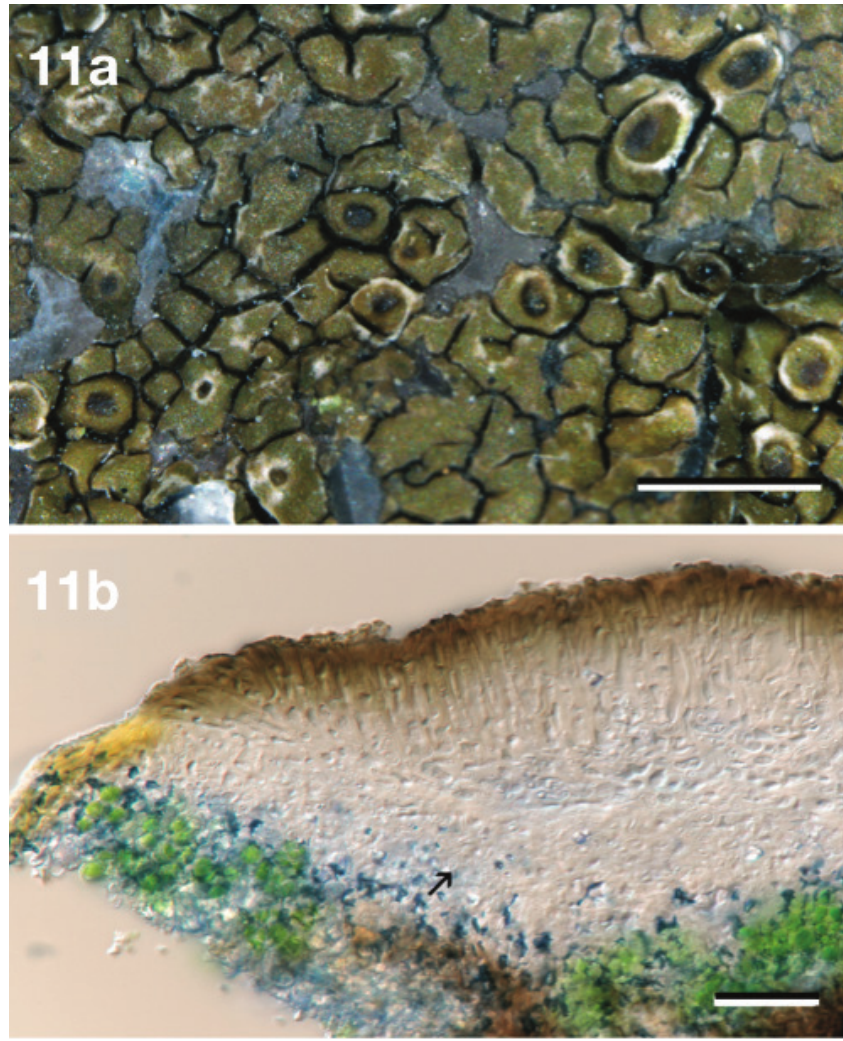
Figure 11. Neoprotoparmelia pauli , holotype Kirika & Lumbsch 3821 (EA) a Habit b Centre of apothe- cia section, showing cupular proper exciple (arrow). Scale bars: 1 mm ( a ), 20 μm ( b ). irregular, polygonal to rounded, up to 0.75(–1.2) mm in diam., flat to slightly convex, surface mainly smooth, marginal areoles sometimes lobe-like. Apothecia frequent, 1 per areolae, zeorine to lecanorine, mainly immersed and nearly urceolate or adnate, rounded, up to 0.4 mm in diam.; disc brown to brown-black, dull, concave to flat; thalline exciple persistent, concolorous with thallus to whitish (by a strong mucilagi- nous epicortex); proper exciple cupulate, up to 35 μm thick, coherent, hyphae mainly periclinal with strong mucilaginous walls. Hymenium hyaline, coherent, 35–60 μm tall; epihymenium light brown to brown, up to 15 μm tall, with few irregular